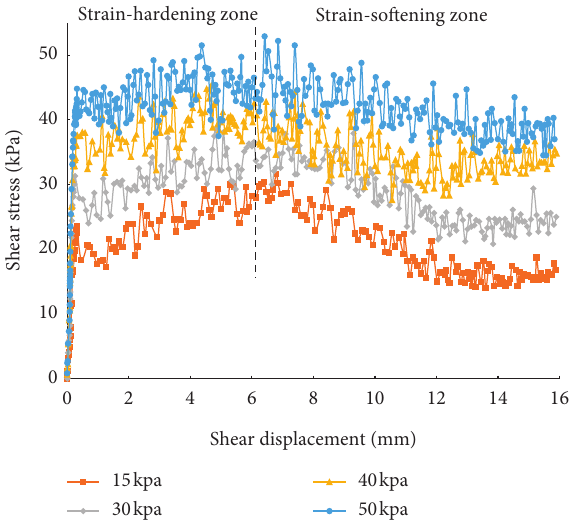
Figure 10: Shear stress-shear displacement curve of 0.2cm vertical kraft paper-reinforced